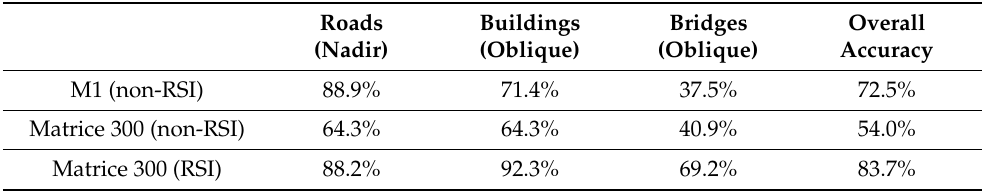
Table 5. Mask R-CNN classification accuracy in mIoU percent, by sUAS platform type, acquisition method, feature type, and view